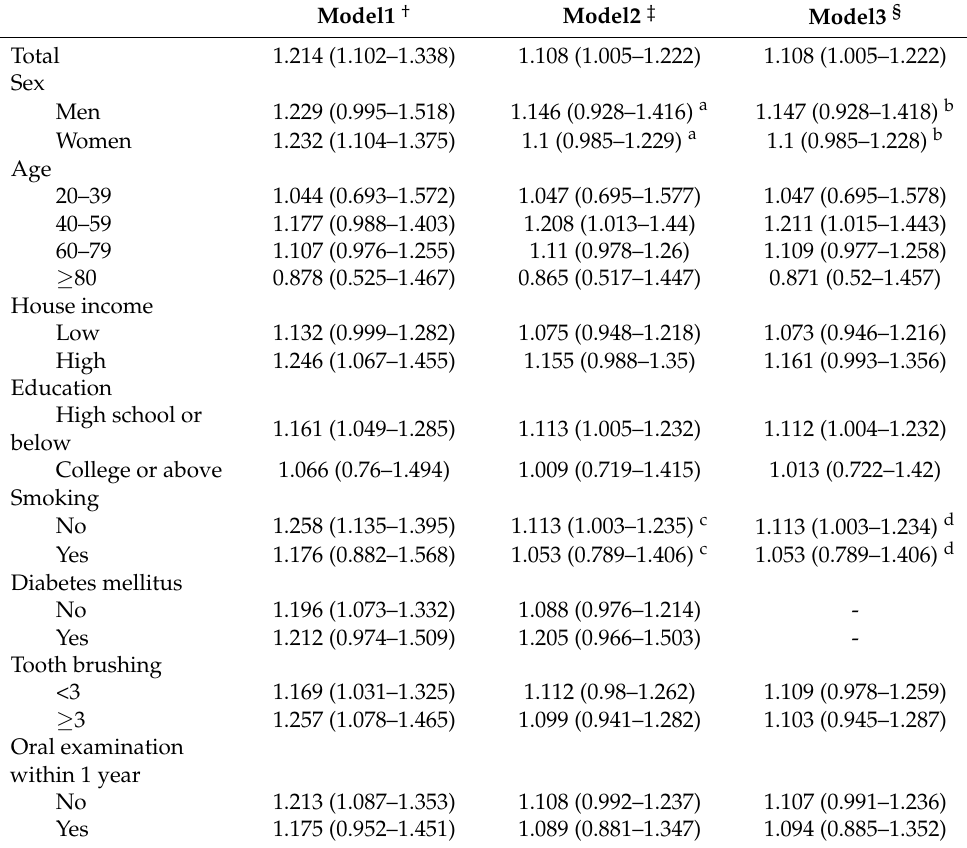
Table 2. Odds ratios of self-perceived oral health according to rheumatoid